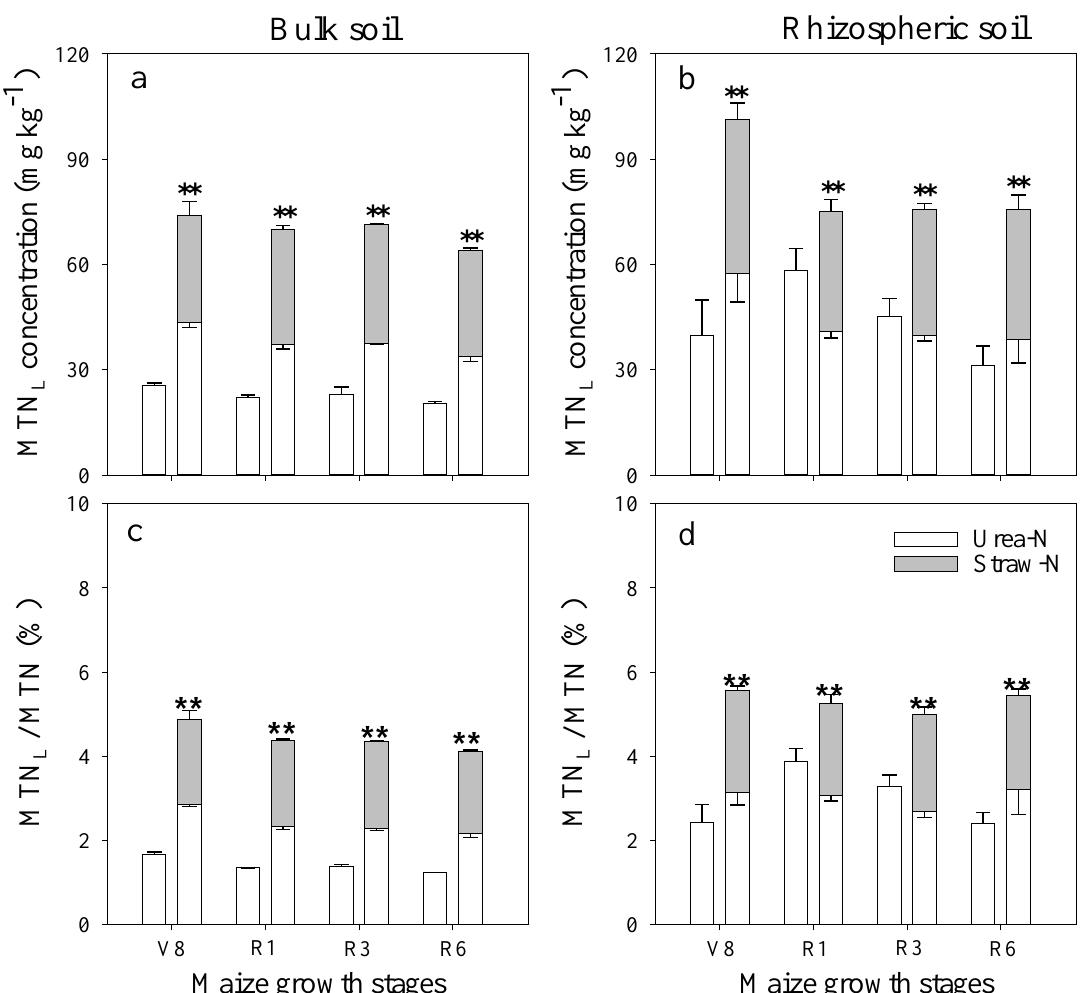
Figure 8. Concentration ( a , b ) and percentage ( c , d ) of labeled applied N (N L ) present as mineral associated total N (MTN) in bulk and rhizosphere soil in different fertilizer treatment during maize growth. White-only bars represent urea treatment (U). White plus gray bars represent urea combined with straw treatment (US). Maize growth stage: V8, R1, R3, and R6 respectively represent 8th leaf stage, silking stage, milk stage, and physiological maturity. Data shown are mean ± standard deviation of three replicates; ** denote significant differences at p < 0.01.